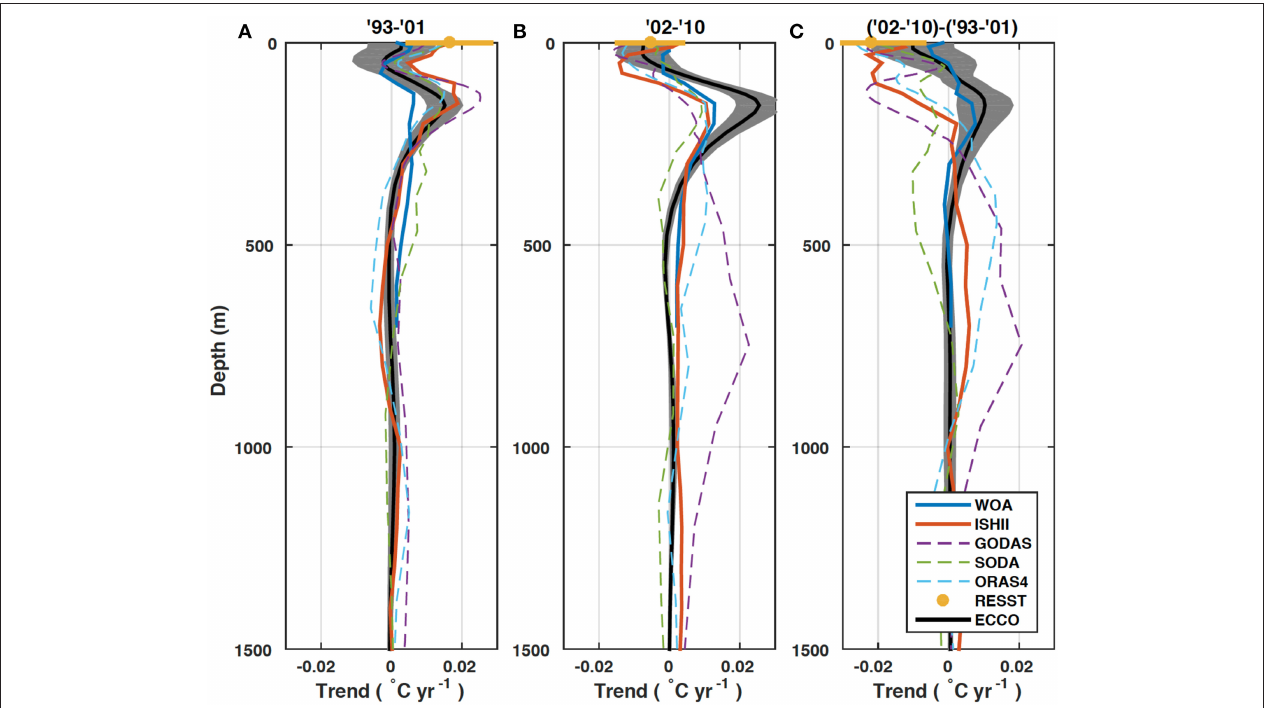
FIGURE 1 | Decadal trends in global mean potential temperature as function of depth over the periods 1993–2001 (A) , 2002–2010 (B) , and their difference (C) , inferred from two hydrographies, three ocean reanalysis and the ECCOv4 state estimate. Black: ECCOv4 (gray shading indicates formal standard error, see main text), dark blue: WOA (Levitus et al., 2012); red: Ishii (Ishii et al., 2005); purple: GODAS (Huang et al., 2010); green: SODA (Carton and Santorelli, 2008); light blue: ORAS4 (Balmaseda et al., 2012); yellow: SST (Reynolds et al., 2002). Adapted from National Academies of Sciences, Engineering, and Medicine (2016) (their Figures 4,